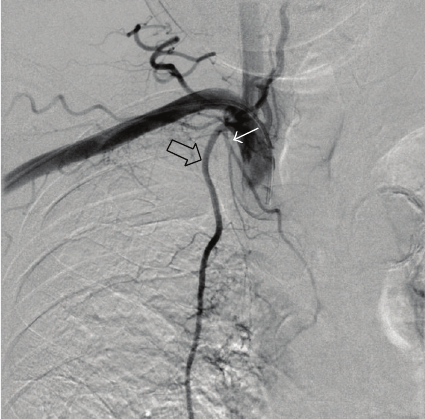
Figure 2: Angiogram of the brachiocephalic artery shows the hypertrophic aberrant bronchial artery (white arrow) arising from the proximal portion of the right internal mammary artery (black arrow), findings that corresponded with the CTA